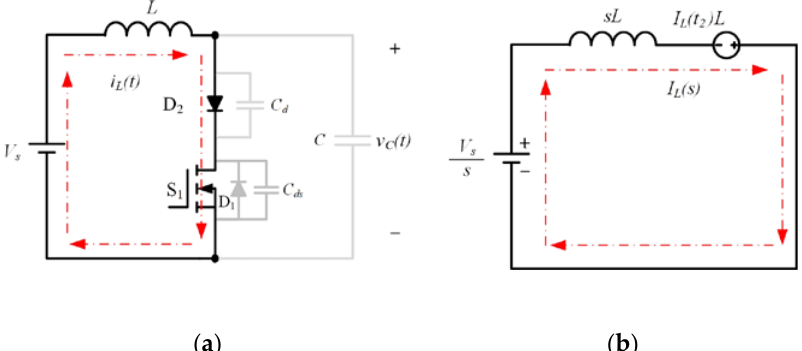
( b ) Figure 5. Mode 2 principle: ( a ) the equivalent circuit; ( b ) the Laplace transform circuit. Mode 3: [ t 2 – t 3 ] During this mode, the resonant capacitor’s voltage rises higher than zero, the diode D 2 is conducted, and the switch S 1 is still turned on. Then, the resonant inductor L is magnetized by the voltage source V s . Thus, i L ( t ) rises linearly and the electrical energy is stored in L . Figure 6a,b depict the equivalent circuit and the Laplace transform circuit, respectively. From Figure 6b, we can obtain the equations 1 ( )